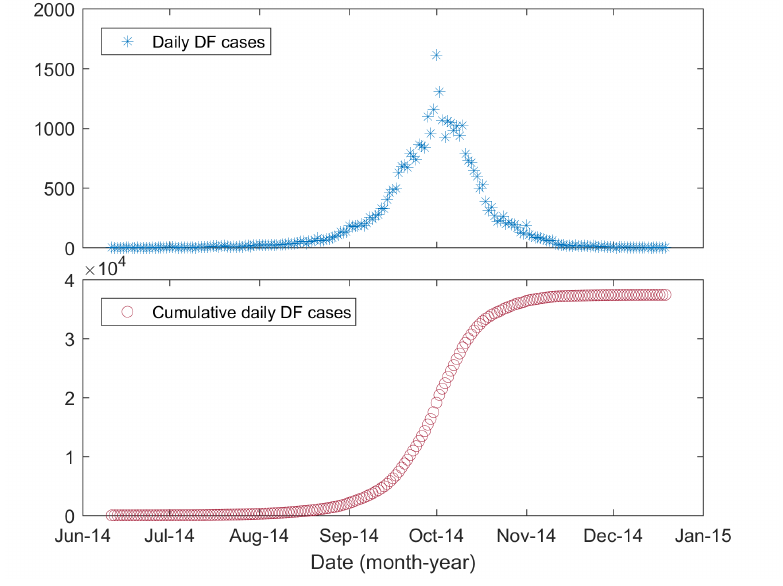
Figure 2. Daily reported and cumulative DF cases in Guangzhou, 2014.